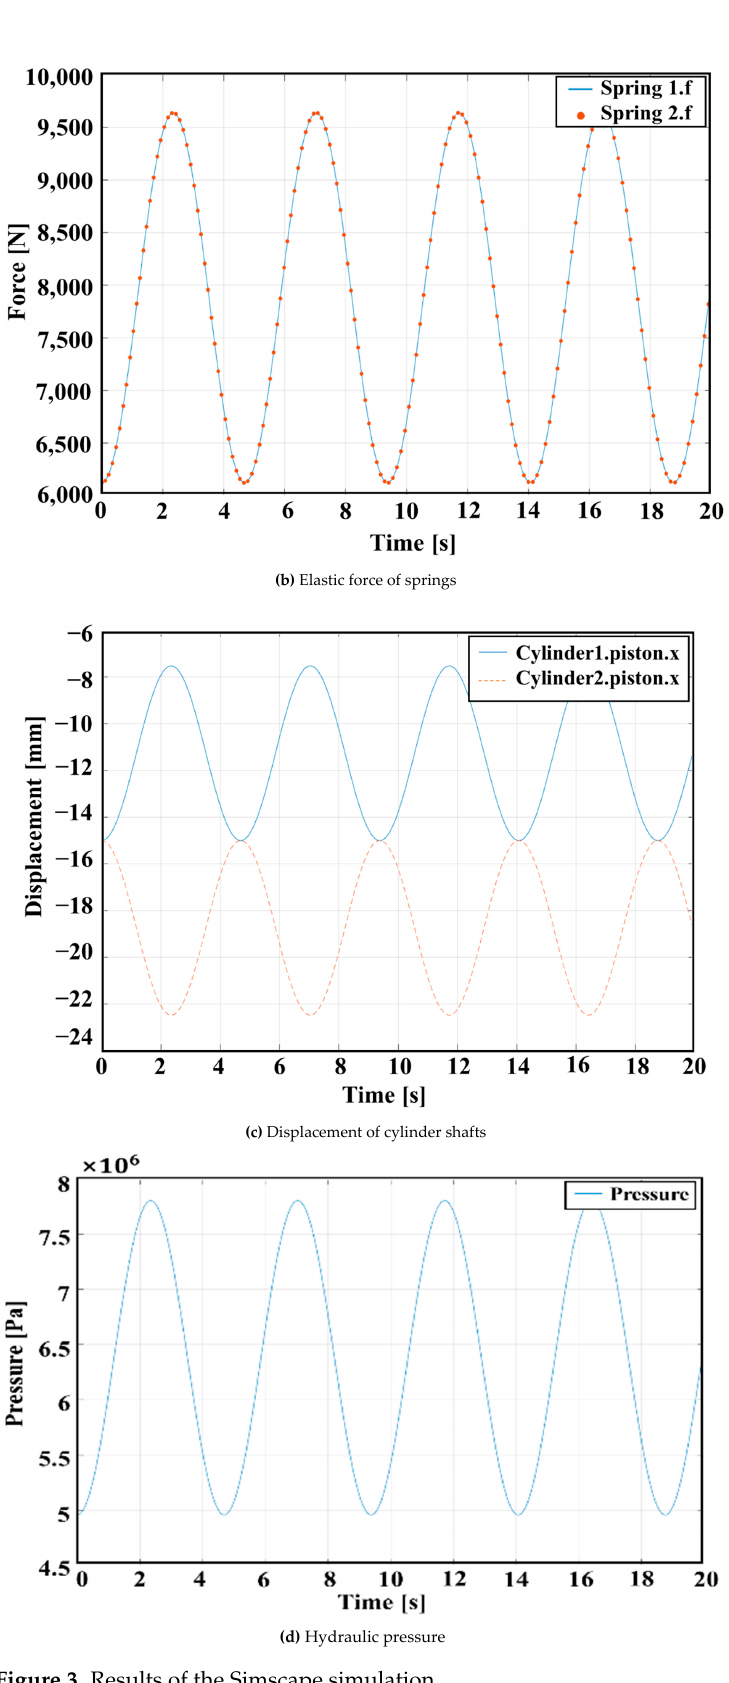
Figure 3. Results of the Simscape simulation.